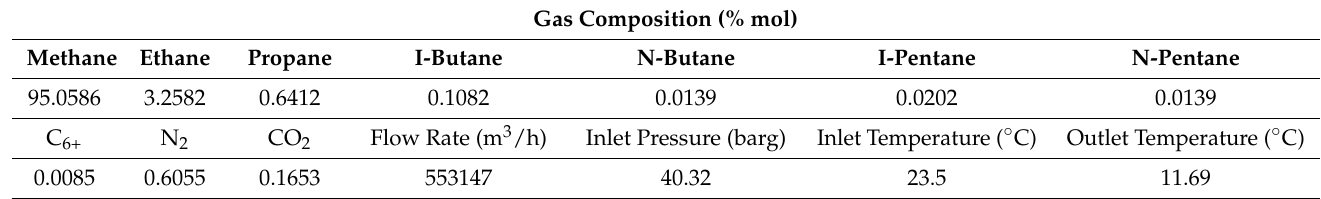
Table 3. Esenyurt RM-A station gas chromatograph values.